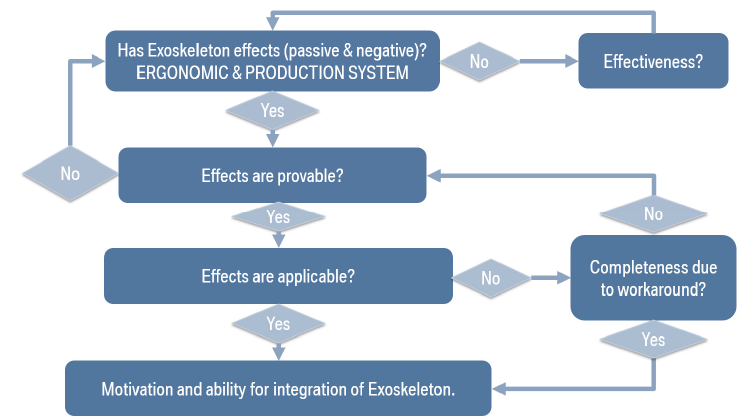
Figure 5. Chain of reasoning to employ exoskeletons in manufacturing workplaces [3].